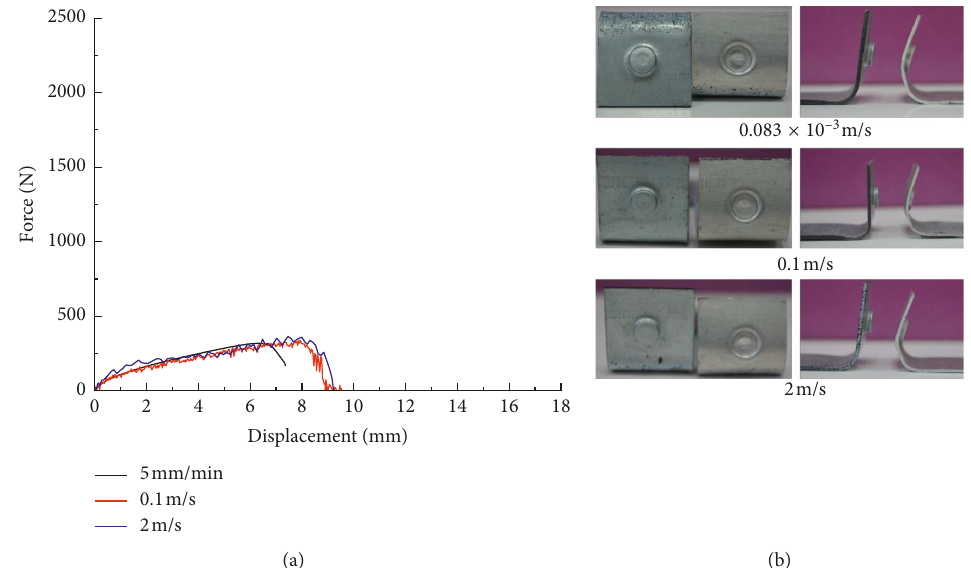
Figure 9: Dynamic coach-peel tests of clinched joints: (a) force-displacement curves and (b) failure modes at three speeds.